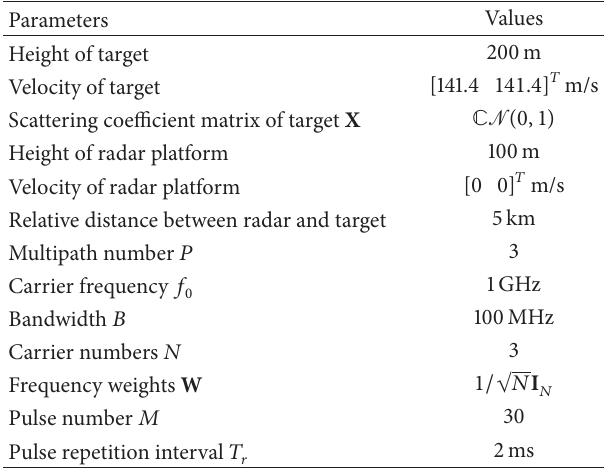
Table 1: Parameter settings of the